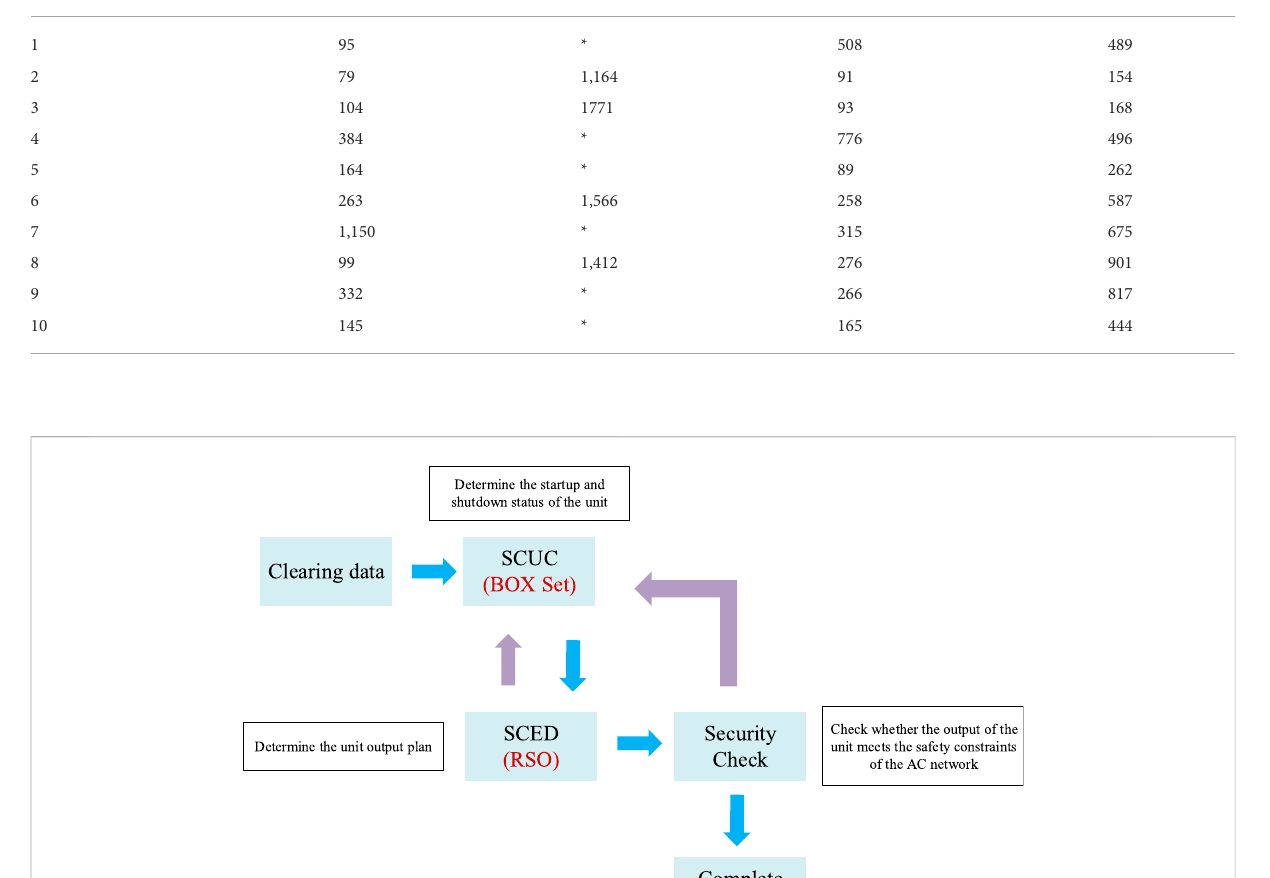
TABLE 1 Comparison results of calculation time of different models under different typical scenarios. Typical scenario